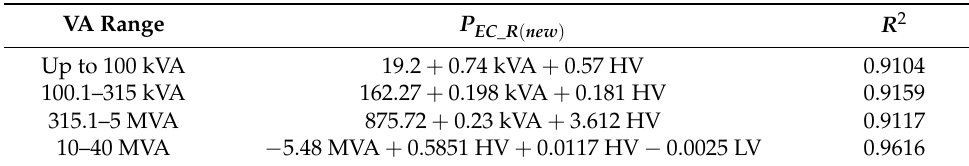
Table 5. Novel regression models for the P EC _ R ( new ) .